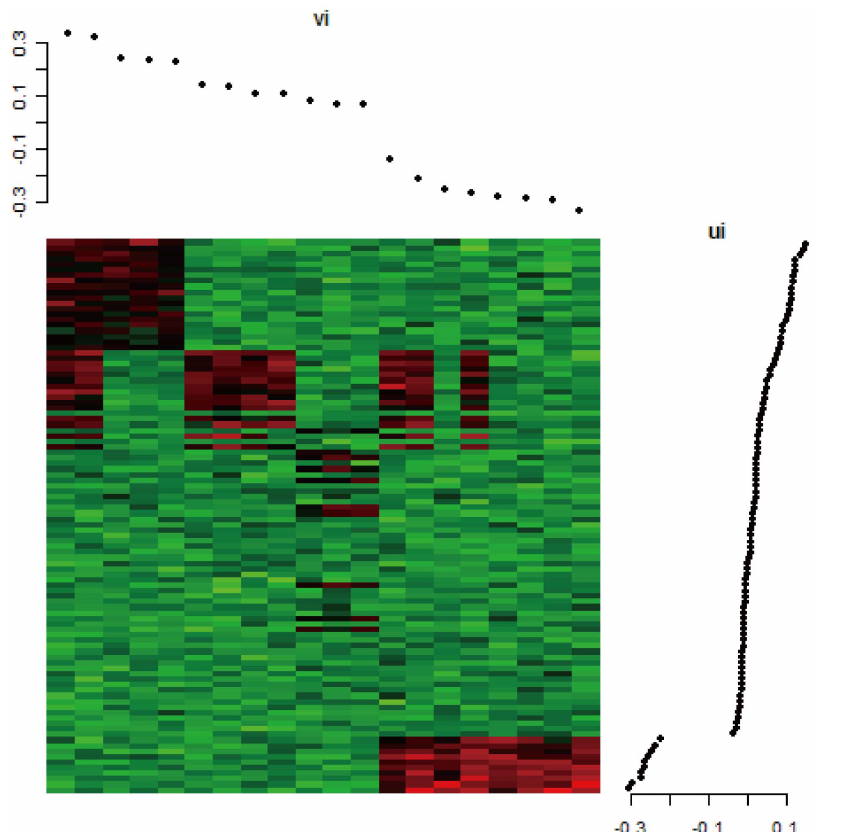
Figure 1. A synthetic data matrix ordered according to magnitudes of the singular vectors of second principal component. The two figures above and to the right of the ordered data matrix are the plots of the corresponding values of the singular vectors.